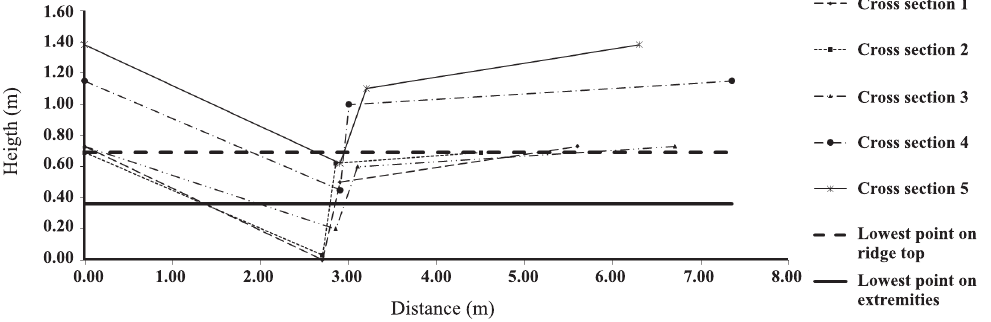
figure 10. Profile and results of terrace 4